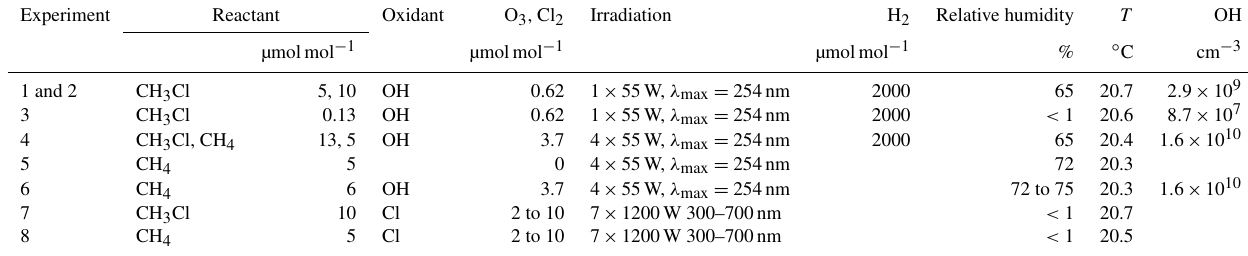
Table 1. Experimental conditions of the degradation experiments with OH. The O 3 mixing ratios are average steady-state mixing ratios throughout the experiment, the Cl 2 mixing ratios refer to the initial mixing ratios at the beginning of each photolysis sequence. Experiment Reactant Oxidant O 3 , Cl 2 Irradiation H 2 Relative humidity